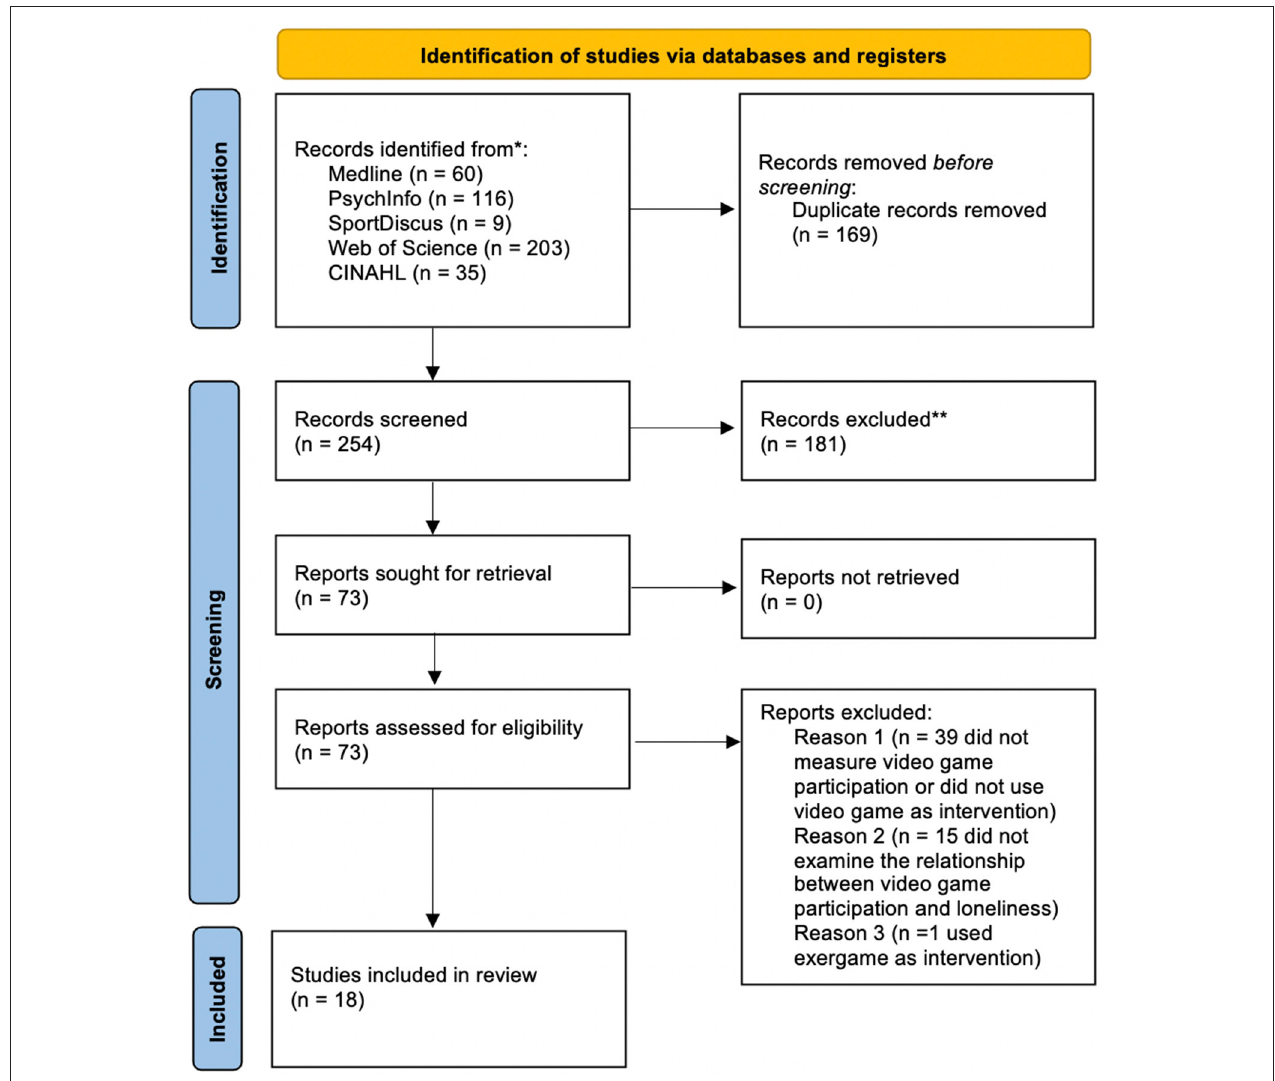
FIGURE 1 | Flow chart of the study selection